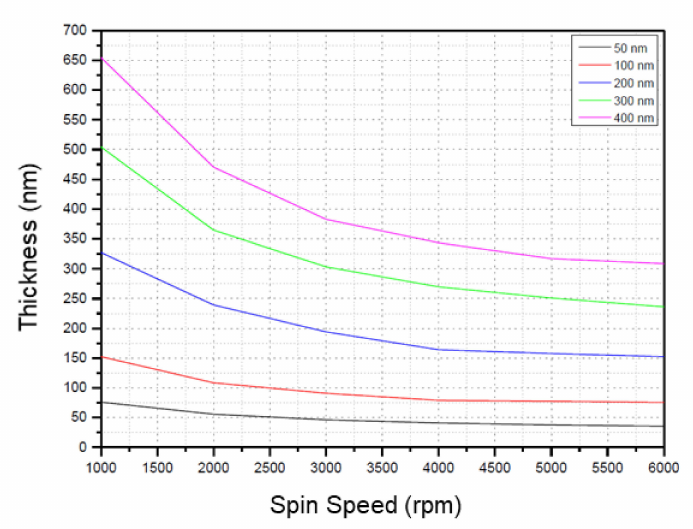
Figure 2. Spin curves of EVG UV-NIL AS with different solvent dilution. The solvent content is optimized for different thickness at 2500 rpm and 60 s spin time. The respective thickness values are shown in the